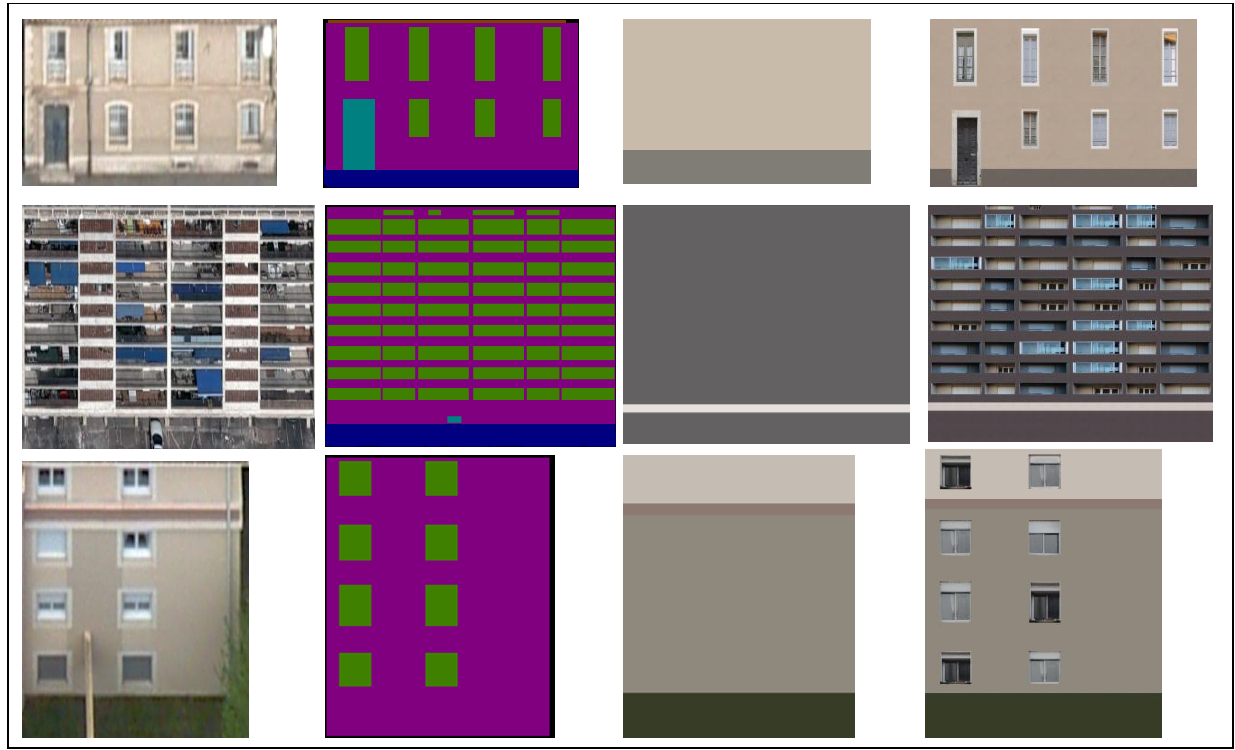
Figure 14. Texture synthesis results for